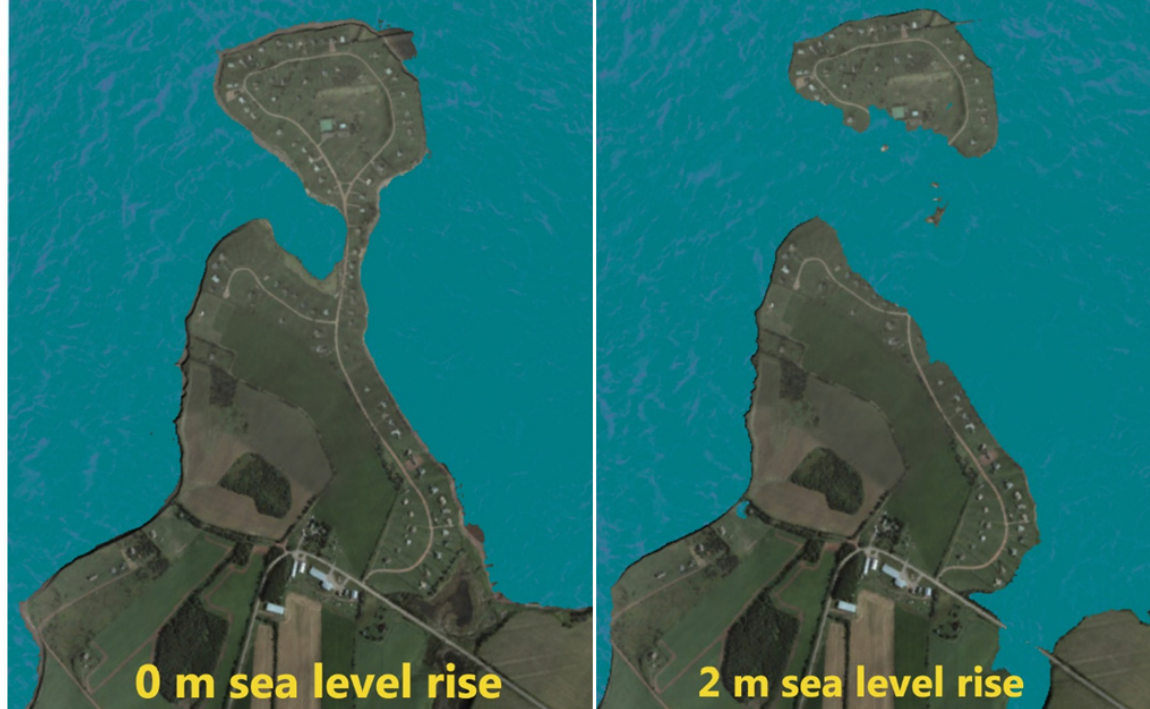
Figure 13. Visualization of areas impacted by 2 m storm surge on MacEwen’s Island.